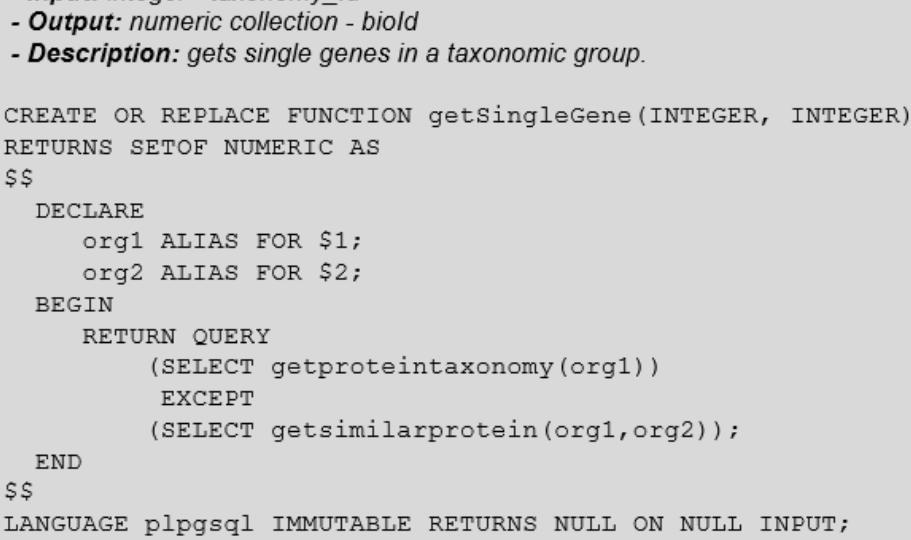
Figure 16. Function: GetSingleGene.